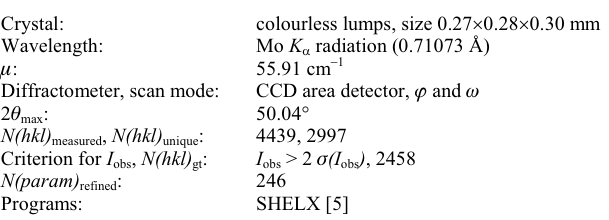
Table 1. Data collection and handling.